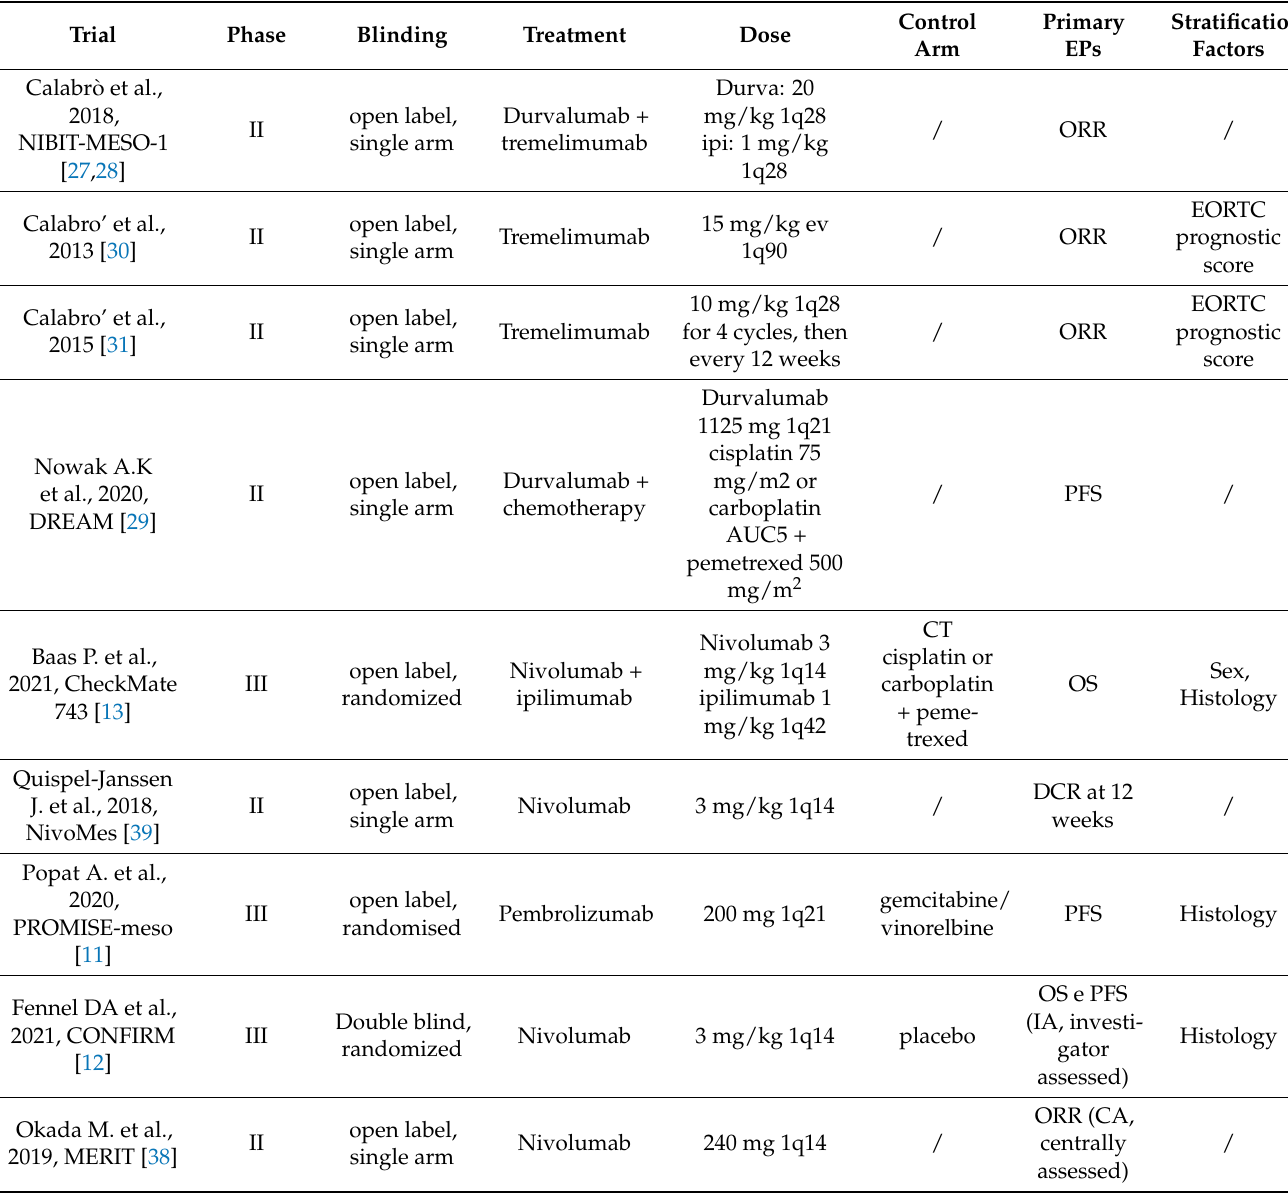
Table 1. Trial design and primary endpoints. ORR: Overall Response Rate, PFS: Progression Free Survival, OS: Overall Survival, DCR: Disease Control Rate, CA: Centrally Assessed, IA: Investigator